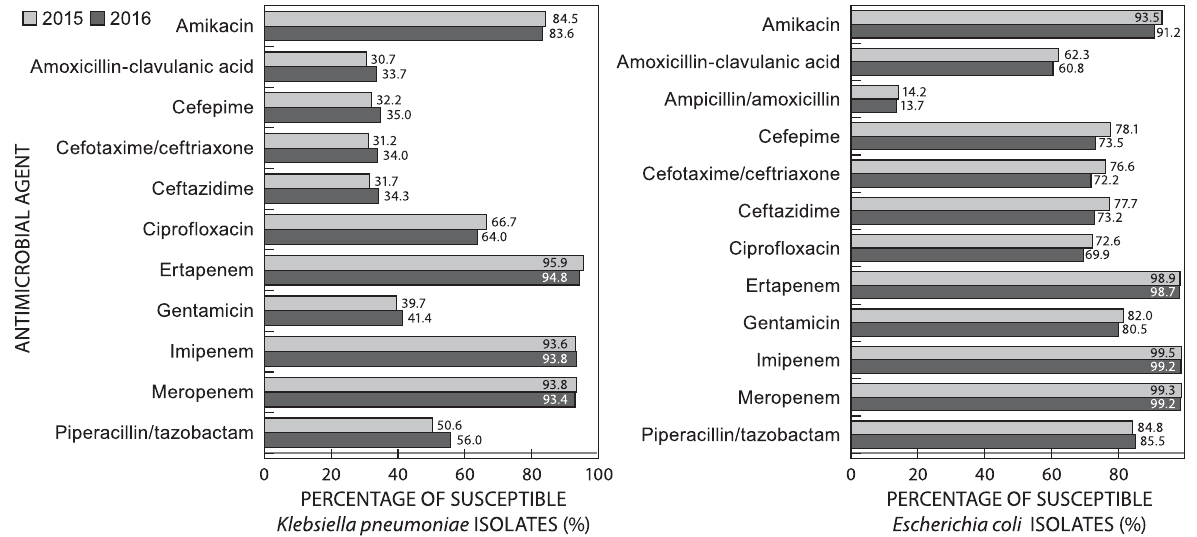
Figure 2: Percentage of susceptible Klebsiella pneumoniae and Escherichia coli isolates, 2015 to